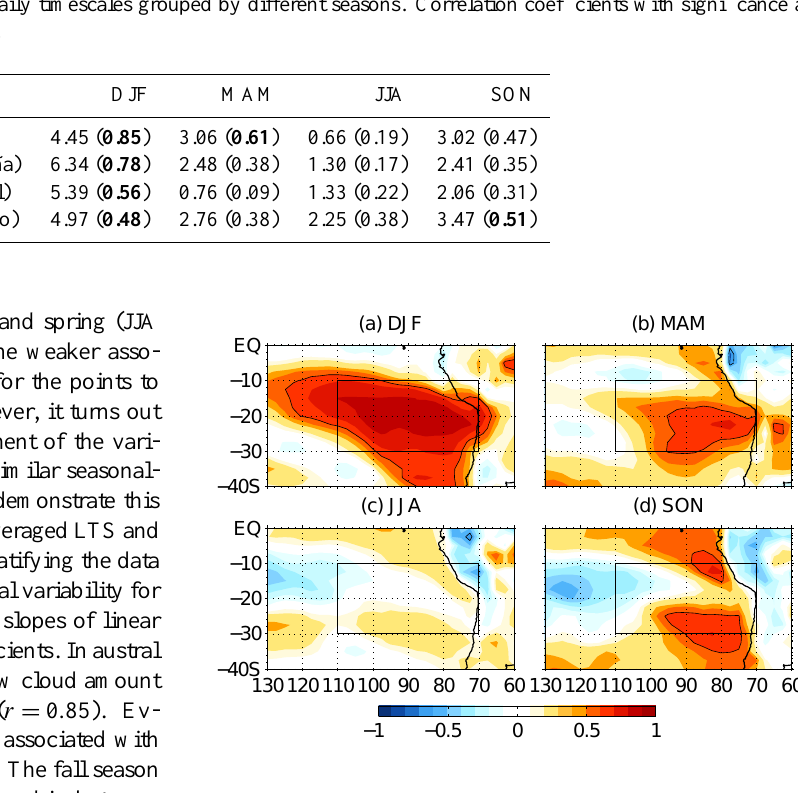
Fig. 5. Correlation of seasonal mean, area-averaged adjusted low cloud amount with LTS at each grid point for season (a) DJF, (b) MAM, (c) JJA and (d) SON. Contour line denoting the 95% significance level using the Student-t test is